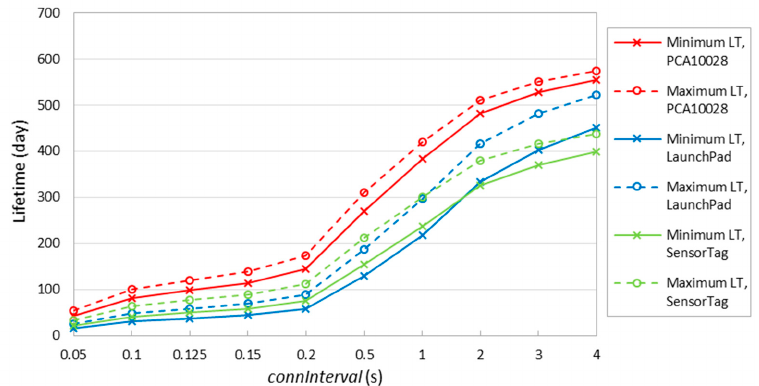
Figure 16. Device lifetime for the different devices considered. Minimum and maximum lifetimes correspond to data interval equal to connInterval and infinity, respectively.